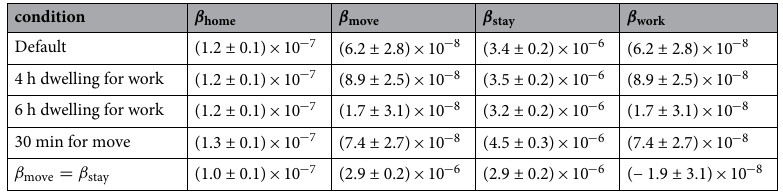
Table 1. Sensitivity analysis of the fitting parameters of the effective reproduction number. The default minimum dwelling time for detecting work square is 5 h. The cases of 4 h and 6 h are indicated by ‘4 h dwelling for work’ and ‘6 h dwelling for work’. ‘30 min for move’ represents the case that the minimum moving time is 30 min. ‘ β move = β stay ’ is the case that the parameters are jointly estimated for stay-out and move, instead of for work and